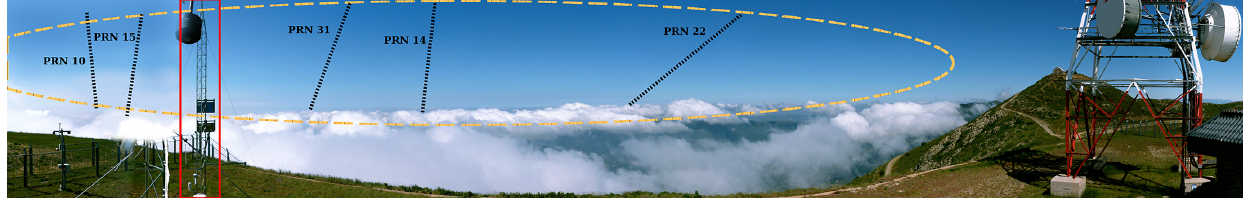
Figure 1. Panoramic view from the observation site. The field of view is the area comprising azimuths from ∼ 150 ◦ (left) to ∼ 270 ◦ (right), looking south. The yellow dashed line indicates the main lobe of the antenna (approximate). The black dashed lines represent the tracks of the GPS satellites followed: from left to right, PRN 10, 15, 31, 14 and 22. Multiple metallic elements seen in the field of view, such as the meteorological station (inside the red outline), the fence, the telecommunications antenna, and others not pictured (metallic shelter, antenna supports, etc.), could affect the GNSS signal in the form of multipath interference.